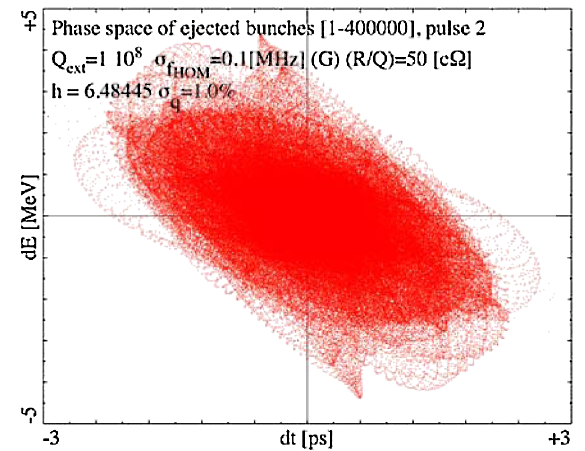
FIG. 10. (Color) Phase space as Fig. 8 but for the 1st pulse (starting with zero volts in ¼ 1% h